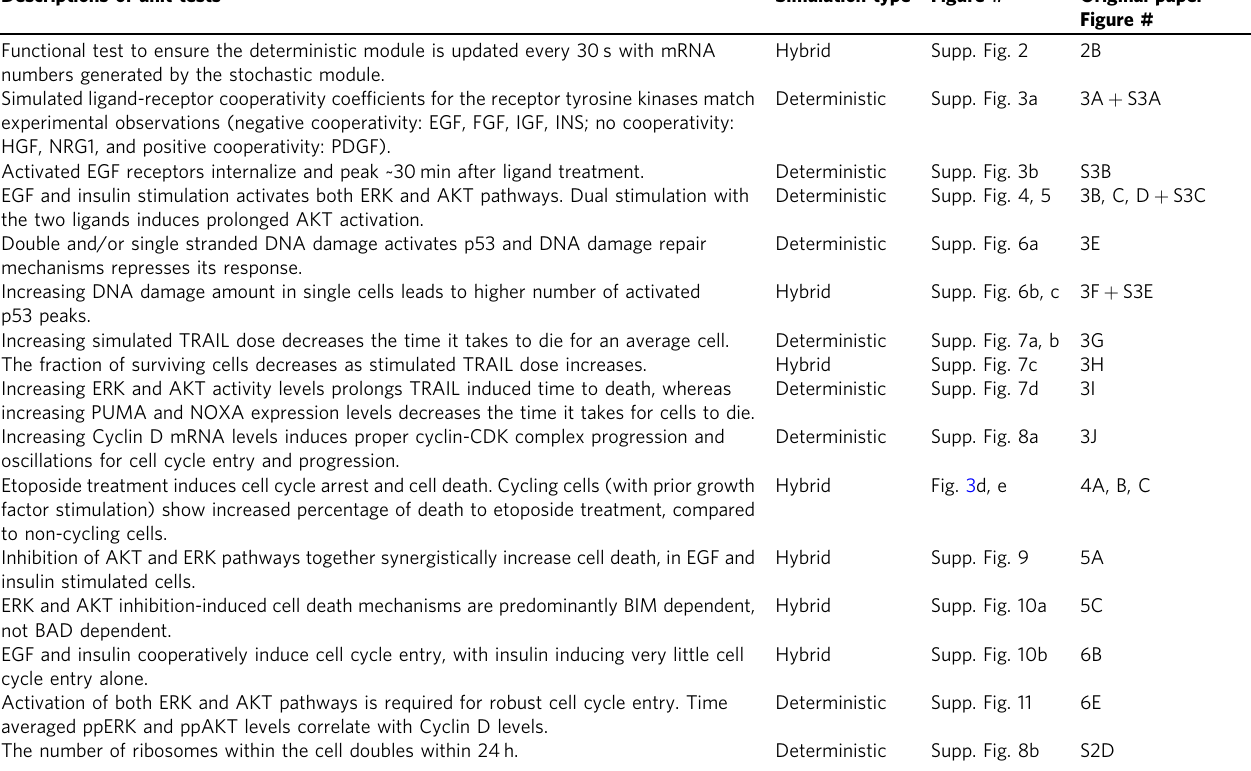
Table 1 List of SPARCED model unit testing and comparisons to Bouhaddou2018